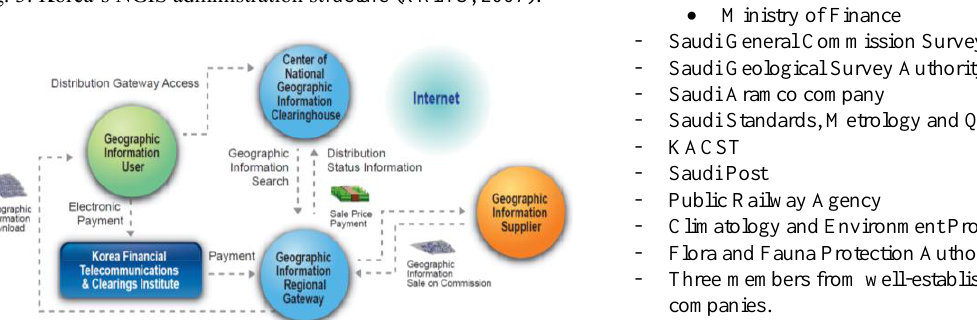
Fig. 3: Korea’s NGIS administration structure (KRIHS, 2007).